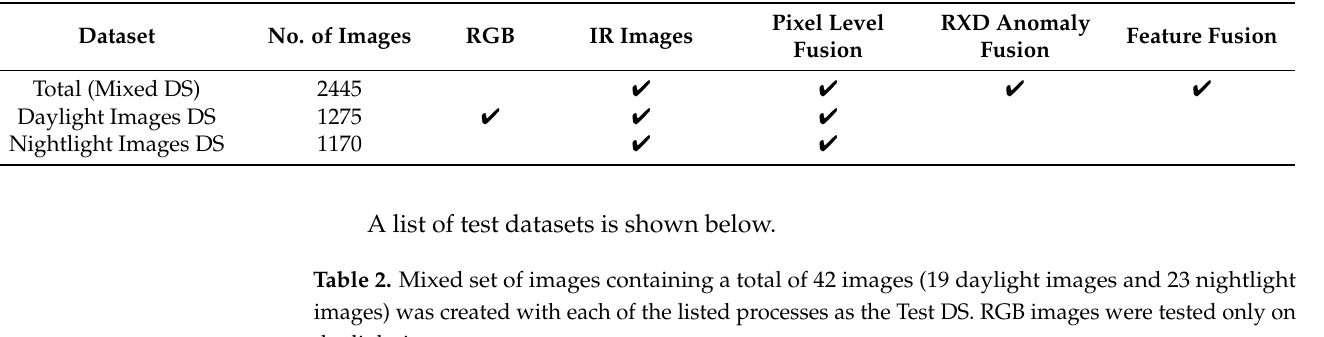
Figure 8. Fused images from feature fusion DS: daylight image FLIR_02163 ( a ); daylight image FLIR_05011 ( b ); nightlight image FLIR_05697 ( c ); and nightlight image FLIR_08926 ( d ).